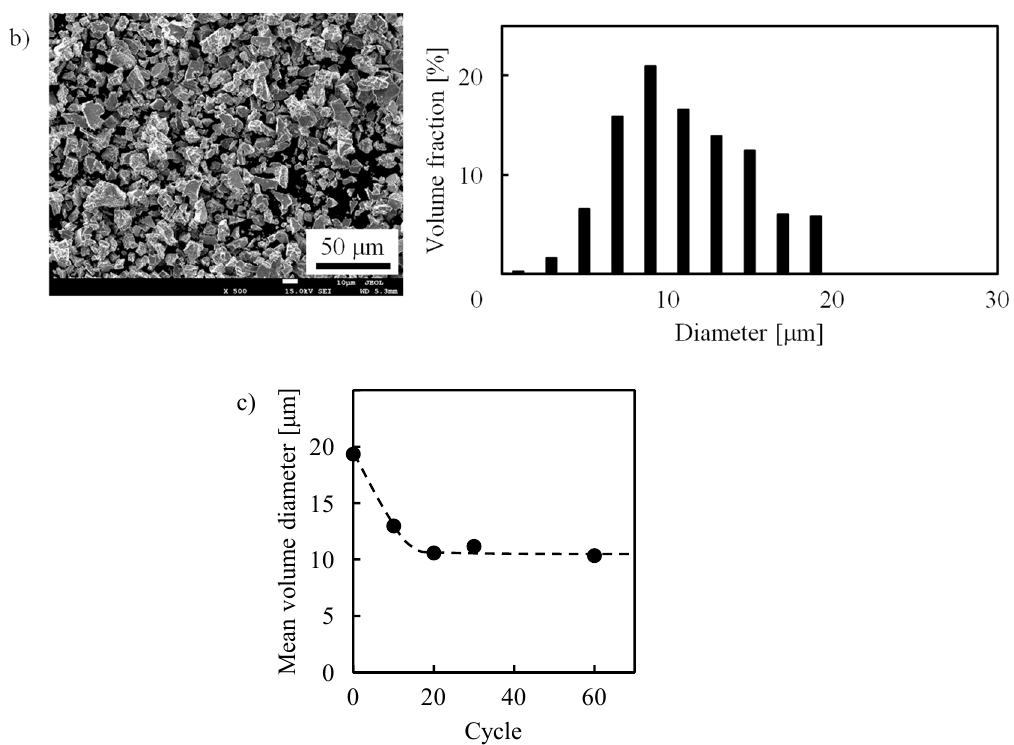
Figure 5. SEM images and size distributions of LaNi 5 particles after ( a ) 0 and ( b ) 30 cycles of hydrogen charge, and ( c ) variation of mean volume diameter with cycle.